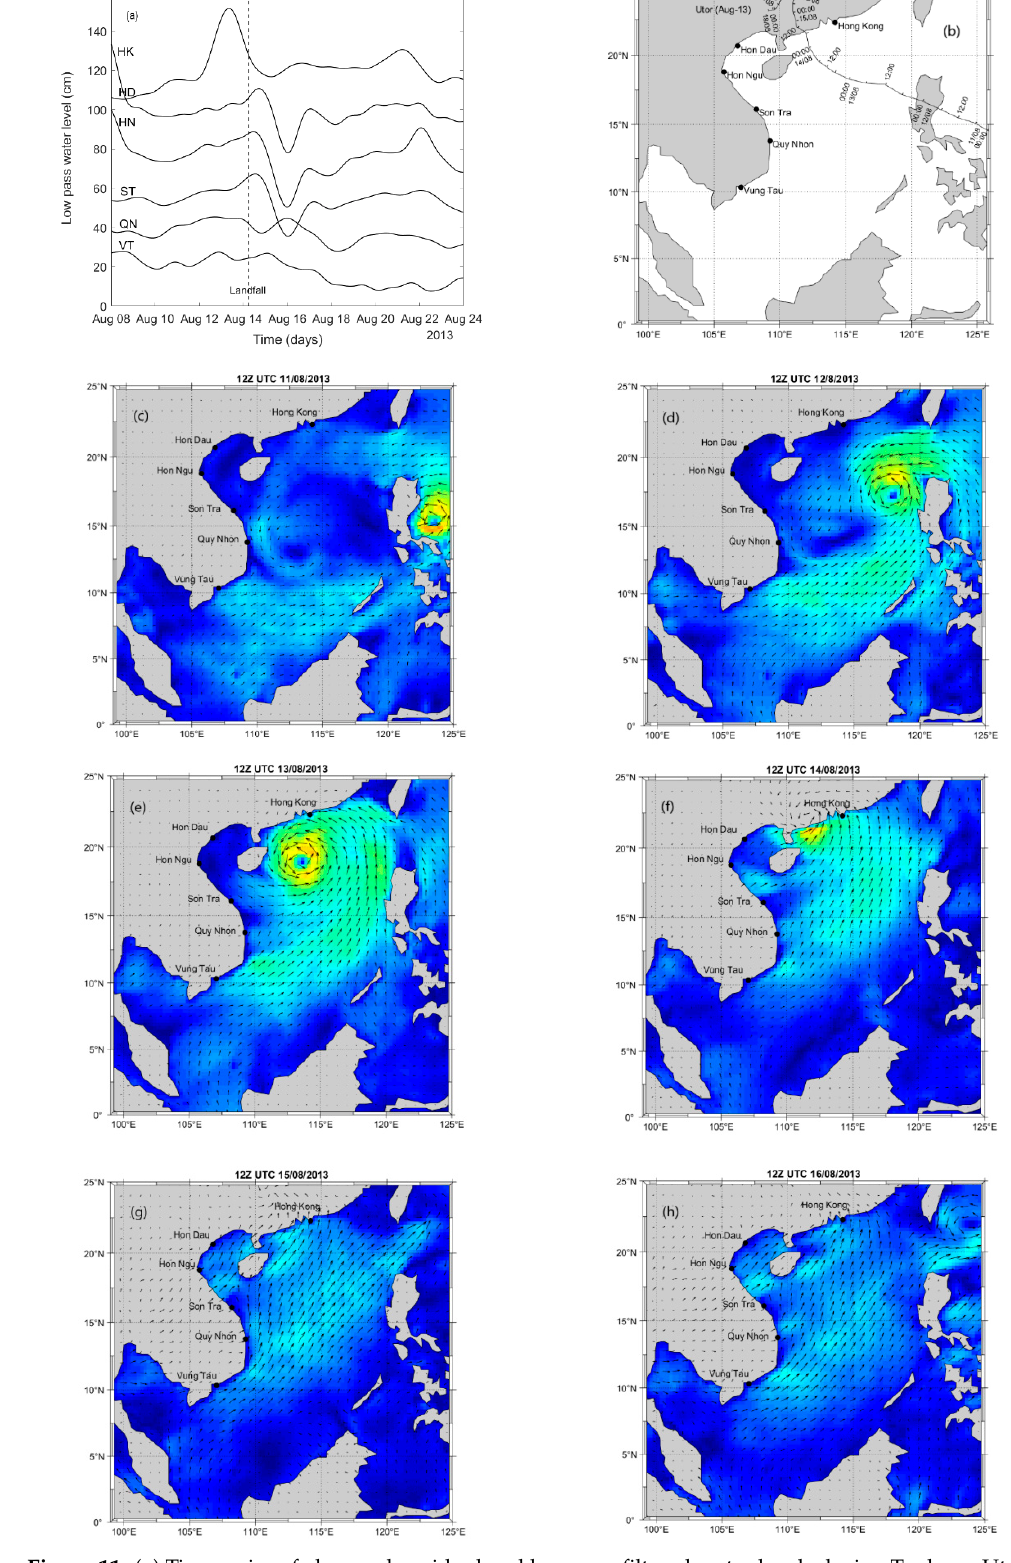
Figure 11. ( a ) Time series of observed, residual and low-pass filtered water levels during Typhoon Utor (9–23 August 2013) at all stations; ( b ) the track of Typhoon Utor; and ( c – h )—wind fields at 12Z UTC from 11 to 16 August 2013. Key: HK: Hong Kong; HD: Hon Dau; HN: Hon Ngu; ST: Son Tra, QN: Quy Nhon; VT: Vung Tau. The wind speed colour scale is given on Figure 9.